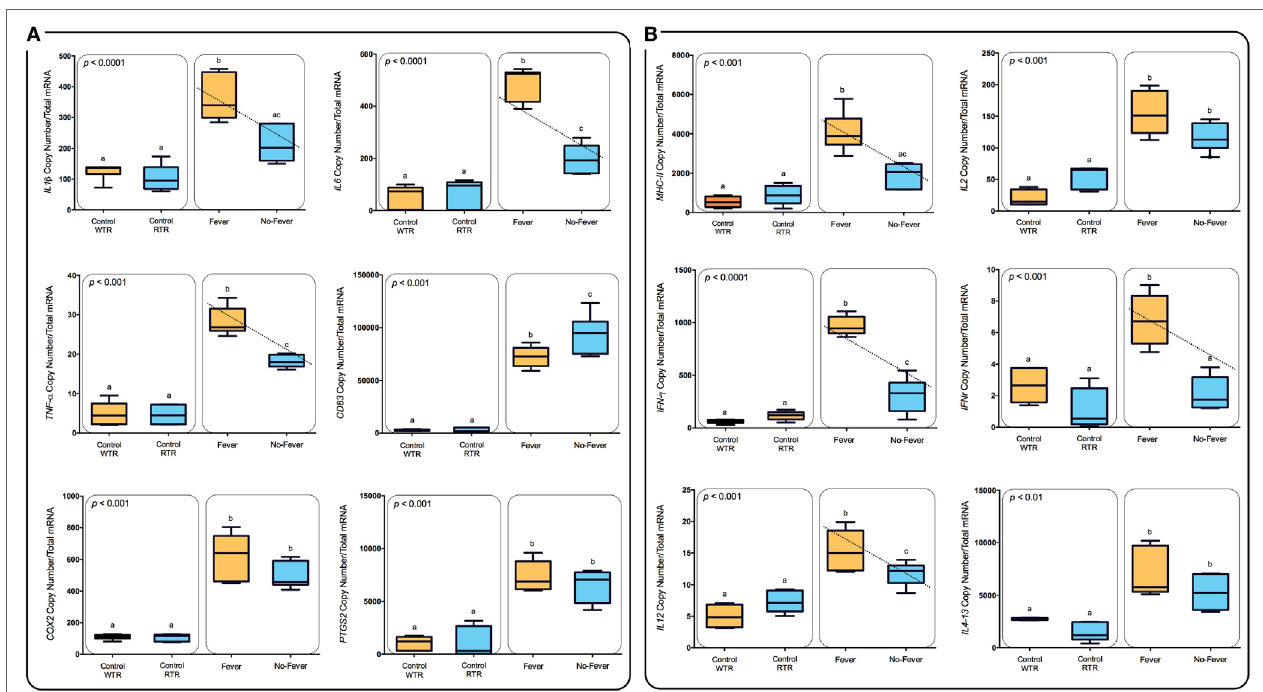
FigUre 6 | Expression profiles among lymphocyte-related immune genes. (a) Box and whiskers plots registered differences in mRNA abundances (back- transformed, ordinary least-squares means) between the thermal treatments are shown for each gene ( MHC-II , IL-2 , IFN- γ , IFNR- γ , IL-12 , and Il4-13 ). Unlike letters denote significantly different mRNA levels between the treatment (two-way ANOVA). (B) Expression profiles among inflammation-related immune genes. Box and whiskers plots registered differences in mRNA abundances (back-transformed, ordinary least-squares means) between the thermal treatments are shown for each gene ( IL1 β , IL-6 , TNF- α , CD83 , COX-2 , and mPGES-1 ). Unlike letters denote significantly different mRNA levels between the treatment (two-way